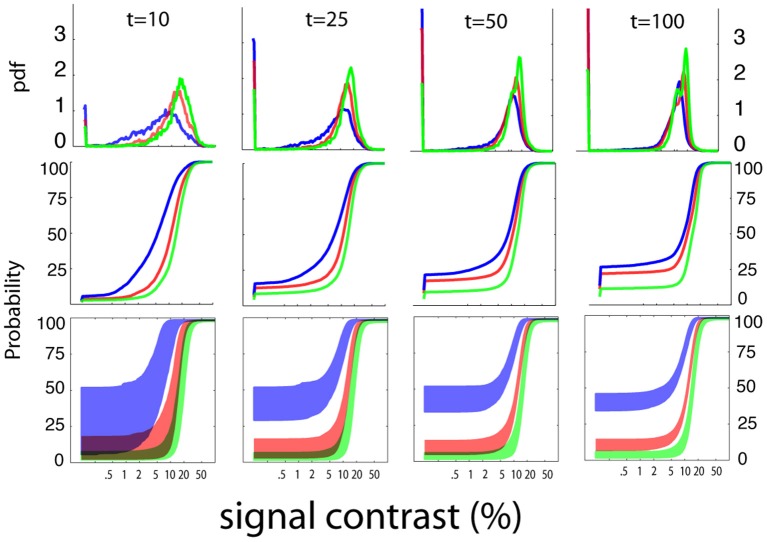
Stimulus sampling. The aggregate patterns of stimulus sampling and psychometric function estimates are presented, for stopping points of 10, 25, 50, and 100 qYN trials, in different columns. To characterize the qYN's stimulus sampling, ordinary histograms (upper row), and cumulative histograms (middle row), are presented as a function of signal contrast. Within 10 trials, sampling is focused to signal contrasts near the sensitivity threshold (10%). As testing progresses, most of the stimulus sampling coincides with the dynamic region of the empirical psychometric function. The sampling pattern also critically depends on the observer's decision criterion.